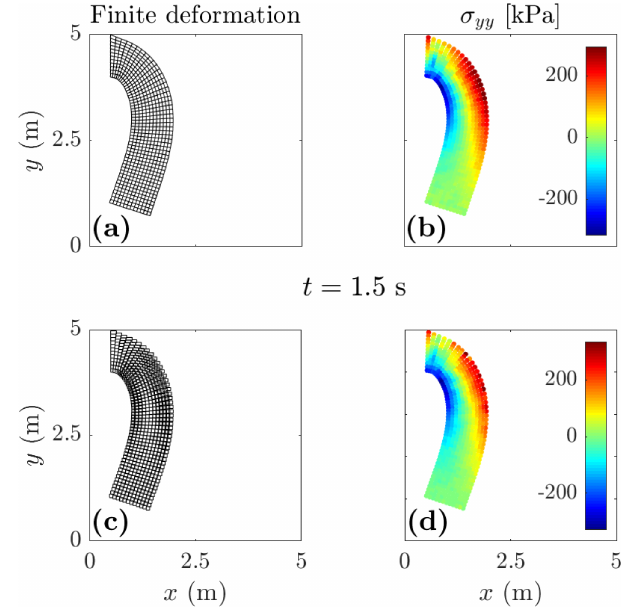
Figure 13. Finite deformation of the material point domain and ver- tical Cauchy stress σ yy for CPDI (panels a and b respectively) and cpGIMPM (panels c and d respectively). The CPDI variant gives a better and more contiguous description of the material point’s domain and a slightly smoother stress field compared with the cpGIMPM variant, which is based on the stretching part of the de- formation